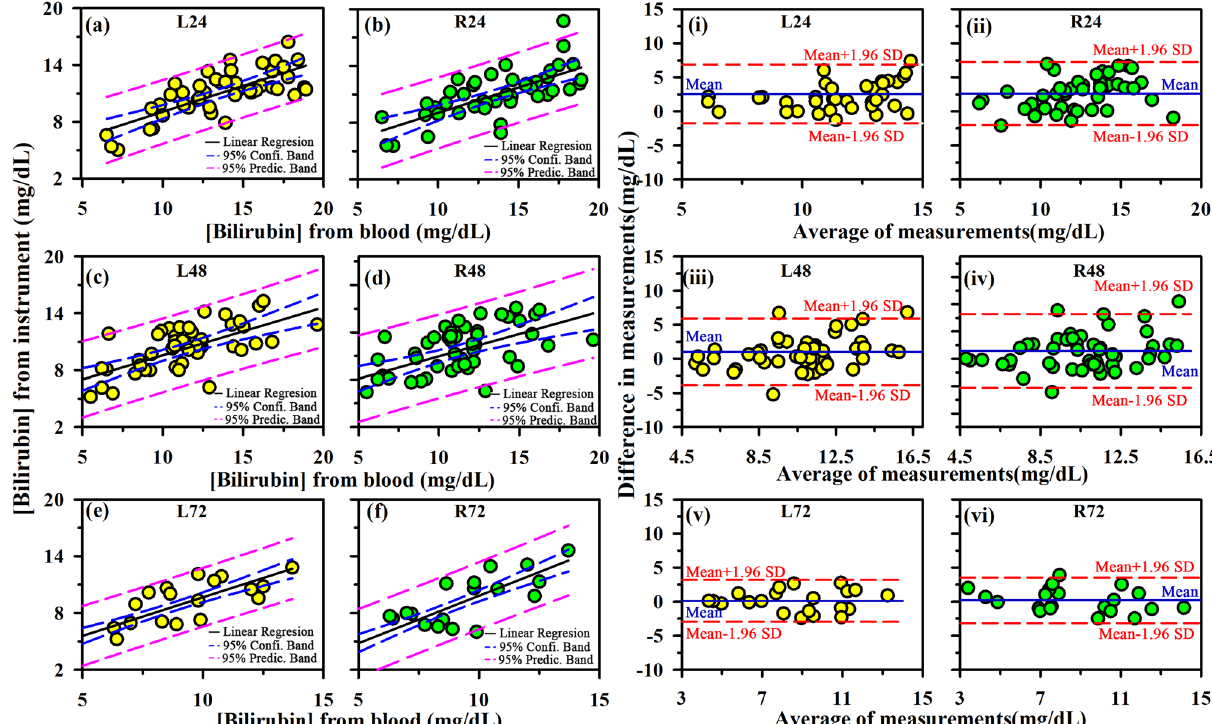
Figure 3. Relationships in matched AJO-Neo and TSB values at different time points of ongoing phototherapy (N = 68). Phototherapy was given following recommendation of AAP based on TSB level, gestational and/ or postnatal age, and associated risk factors. Measurements were performed at 24 h of interval. ( a – f ) Linear regression plot. (i-vi) Bland–Altman plot. L, left nail bed; R, right nail bed; the numbers (i.e., 24, 48, 72) represents the time of